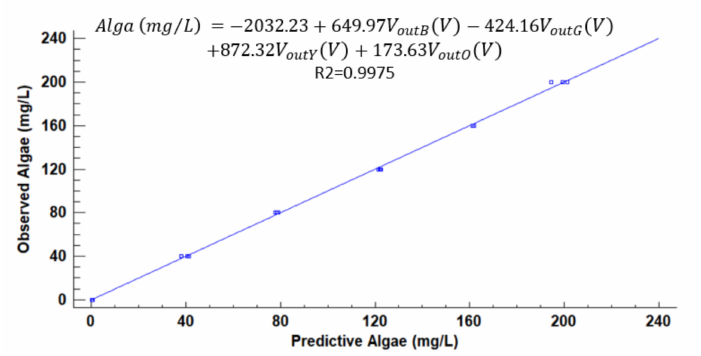
Figure 14. Observed vs. predicted values of algae concentration with a solid concentration of 200 mg/L.